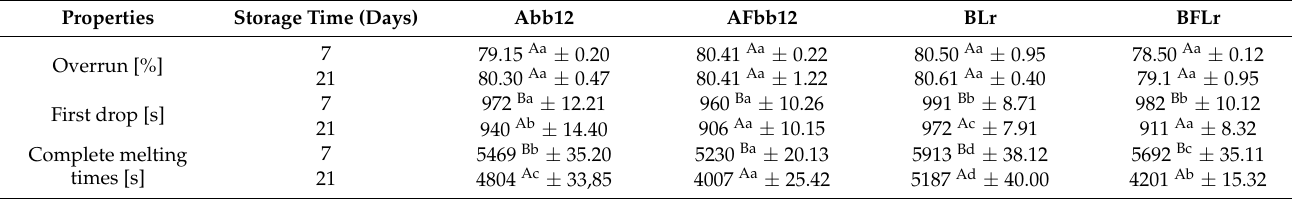
Table 6. Overrun, first dropping time, and total melting rate in 7 and 21 days of